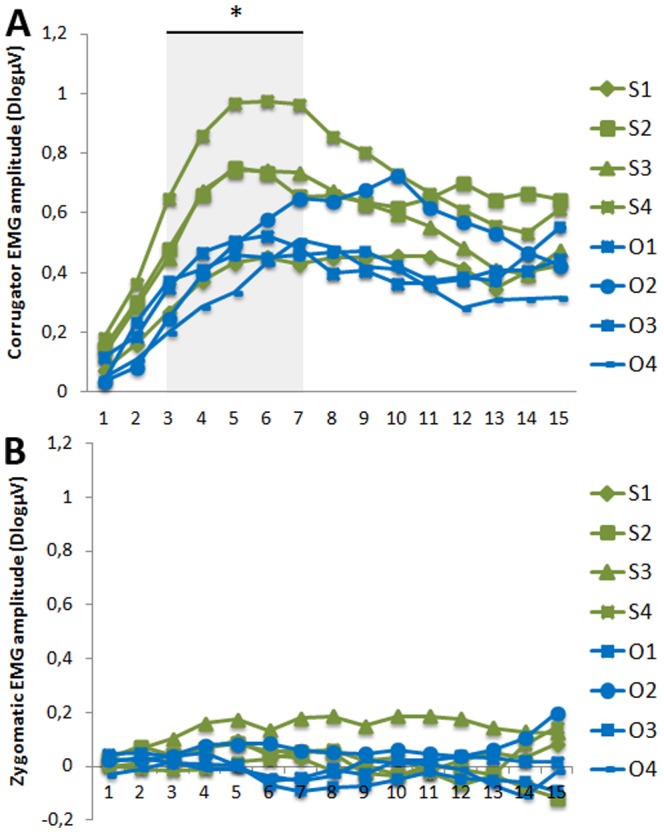
Time course of the mean EMG activity.A) Over the corrugator supercilii region as a function of the Target of Attention (S for Self (green), O for Other (blue)) and the Levels of Emotion (1,2,3,4). Activity reflects average activation during each 100-ms time interval. B) Over the zygomaticus region as a function of the Target of Attention (S for Self, O for Other) and the Levels of Emotion (1,2,3,4).